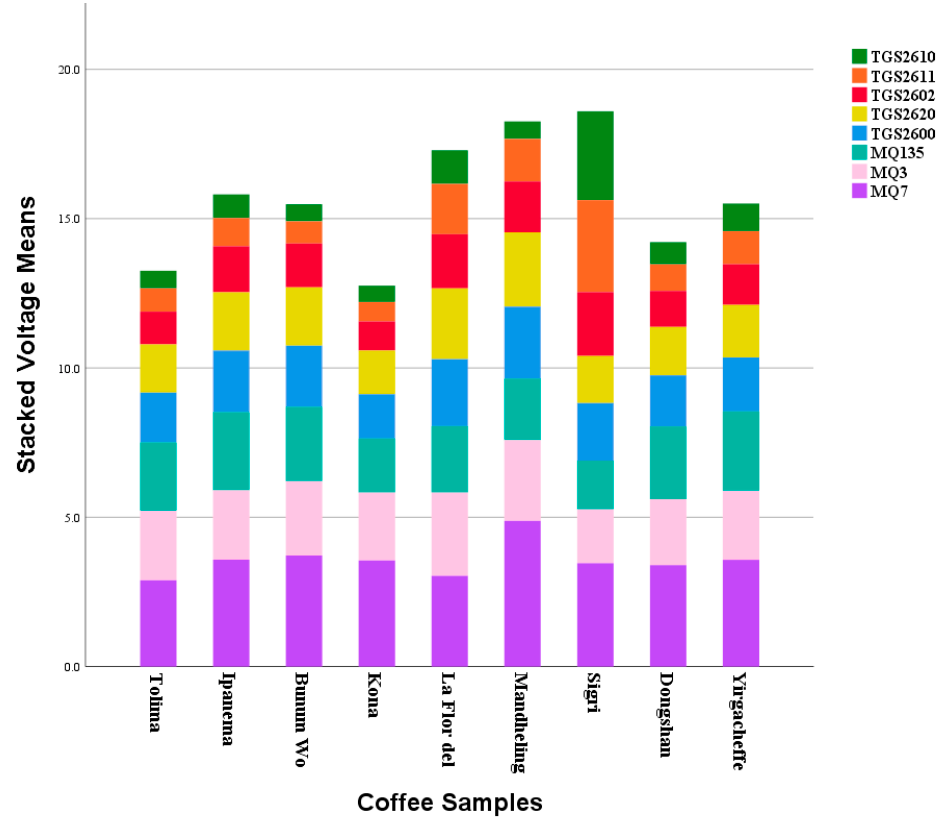
Figure 6. Stacked mean values of the e-nose sensors. Illustration of differences between each sensor for the coffee samples (bar colors).